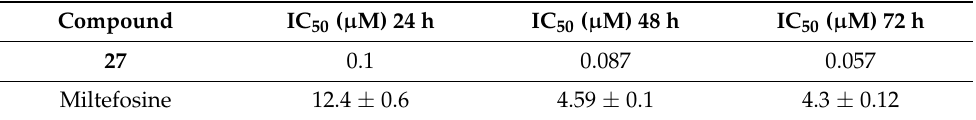
Table 3. In vitro evaluation of the antiparasitic activity against T. cruzi intracellular amastigotes (Y strain) after incubation for 24 h, 48 h or 72 h.